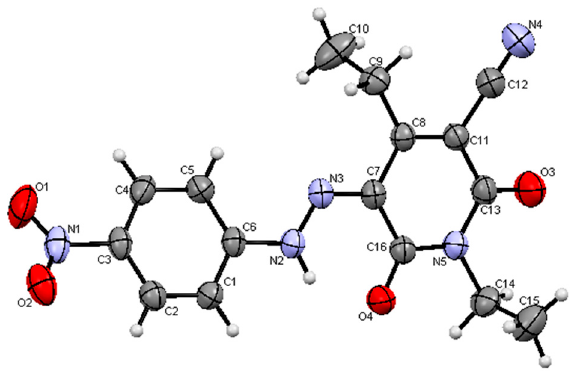
Figure 4. ORTEP of dye 18g.